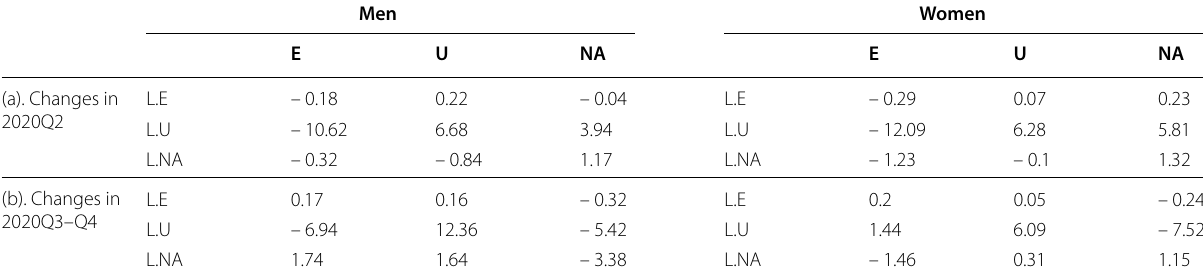
L.E, L.U, L.NA show previous statuses Sample includes respondents aged 15 to 64 for which we have information on employment status in two consecutive quarters. Panels (a) and (b) report the changes in probabilities of status transition from one quarter to the next in 2020Q2 and 2020Q3–Q4 (average of the two quarters), respectively, relative to the year before (pre- COVID times). Results are reported in percentage points E employed, U unemployed, NA